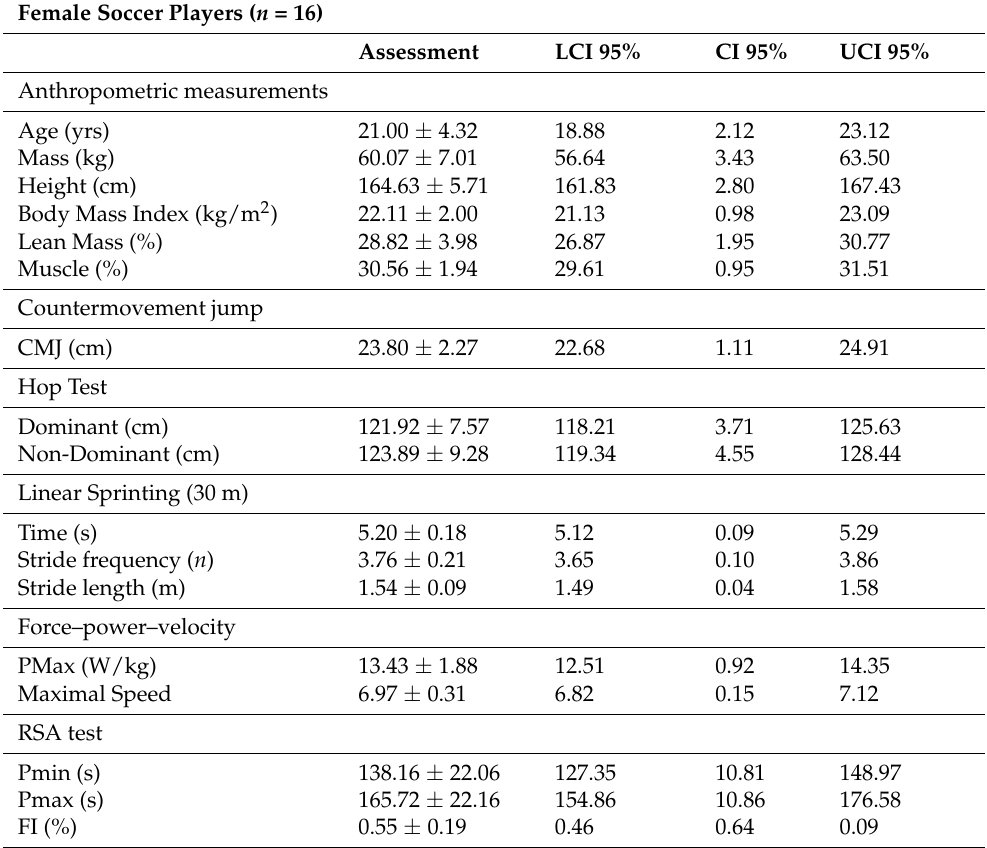
Table 1. Anthropometric measurements and fitness variables at the assessment (mean ±